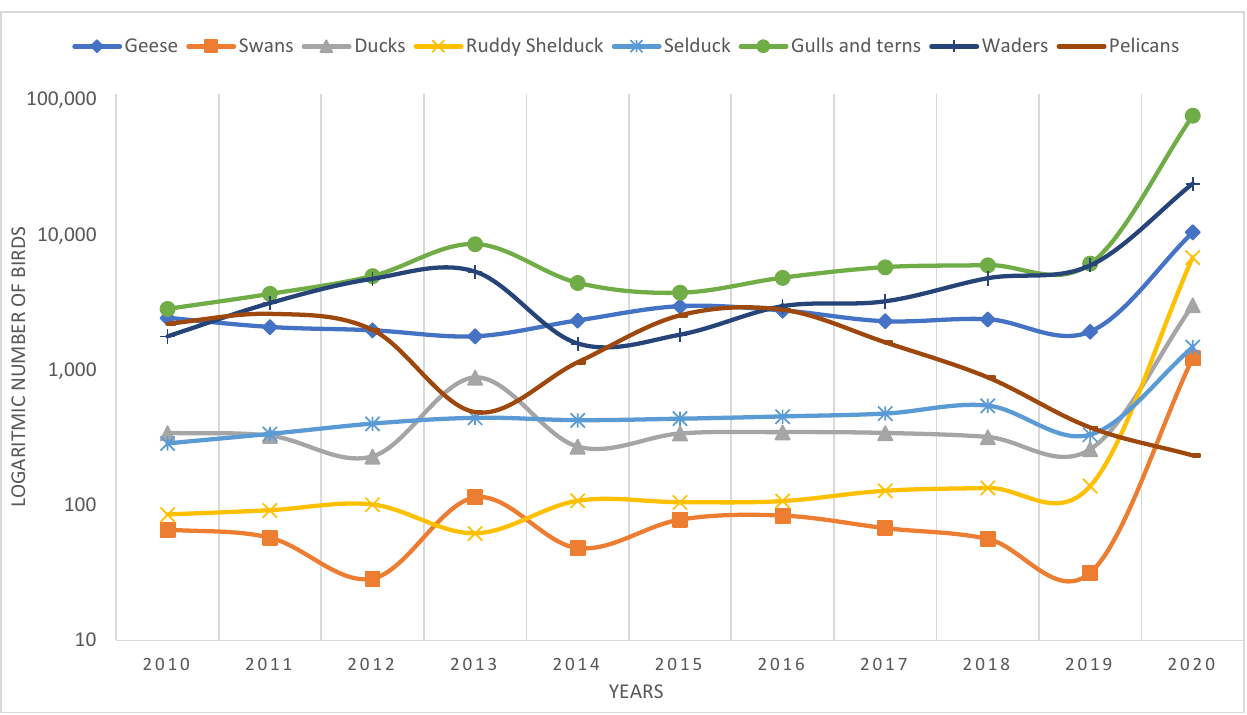
Figure 9. Average number of bird assemblages from 2010–2020.